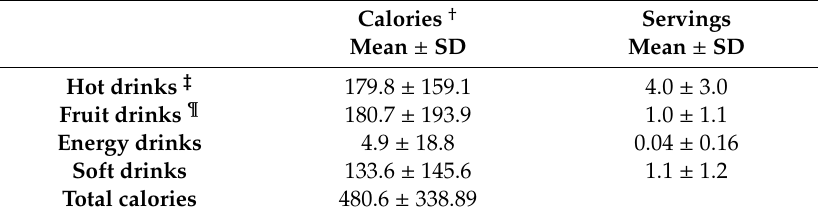
Table 2. Calories and servings consumed per day from SSBs among participants.